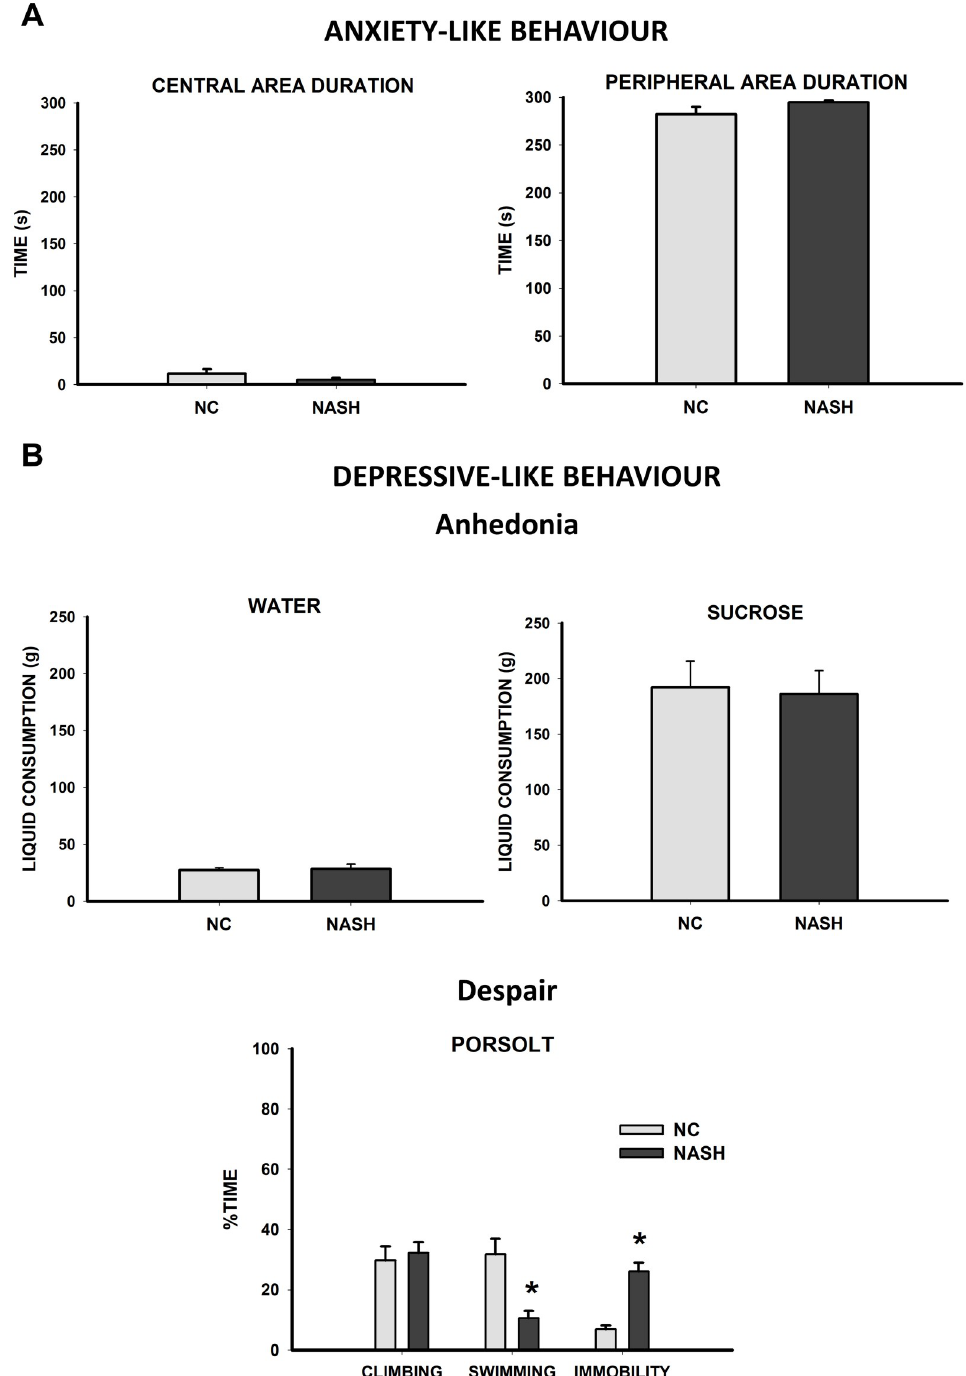
Fig 6. Assessment of anxiety- and depressive-like behavior. ( A ) Anxiety-like behavior was evaluated in the open field exploratory test. Bar charts (mean ± SEM) represent time spent by the experimental groups in the central and peripheral areas. There were no statistically significant differences between groups and the NASH group did not show anxiety-like behavior. ( B ) Depressive-like behavior was evaluated by assessing anhedonia and despair. Anhedonia was measured with the sucrose preference test. Bar charts (mean ± SEM) represent the 24 h consumption of water and sucrose. The NASH group did not show signs of anhedonia. Despair was assessed by the forced swimming test. Bar charts (mean ± SEM) represent the percentage of time spent climbing, swimming, and in immobility in the NC and NASH groups. The NASH group spent significantly less time swimming and more time immobile than the NC group ( � p < 0.05), which is associated with depressive-like